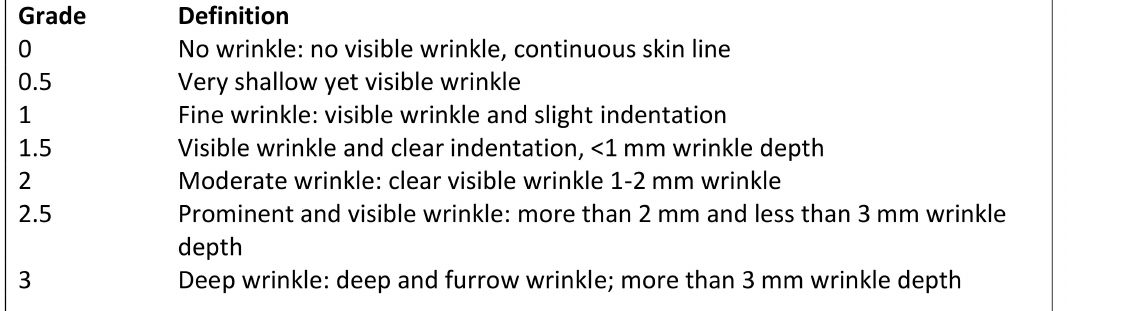
Figure 3. Wrinkle severity scale for nasolabial or periorbital folds (WSS).